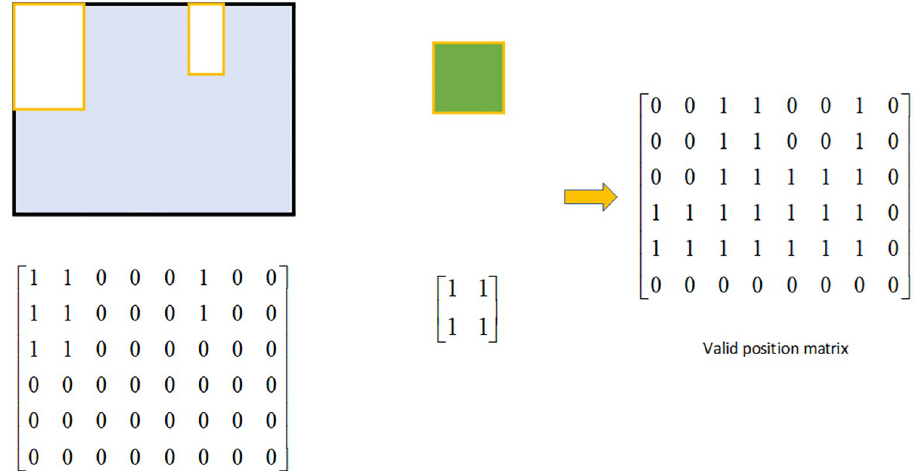
Fig 5. The way to get the valid position matrix. The bin and the parts to be placed are transformed into matrix representation, and the convolution operation is carried out by using the convolution neural network method, and finally the effective position matrix is